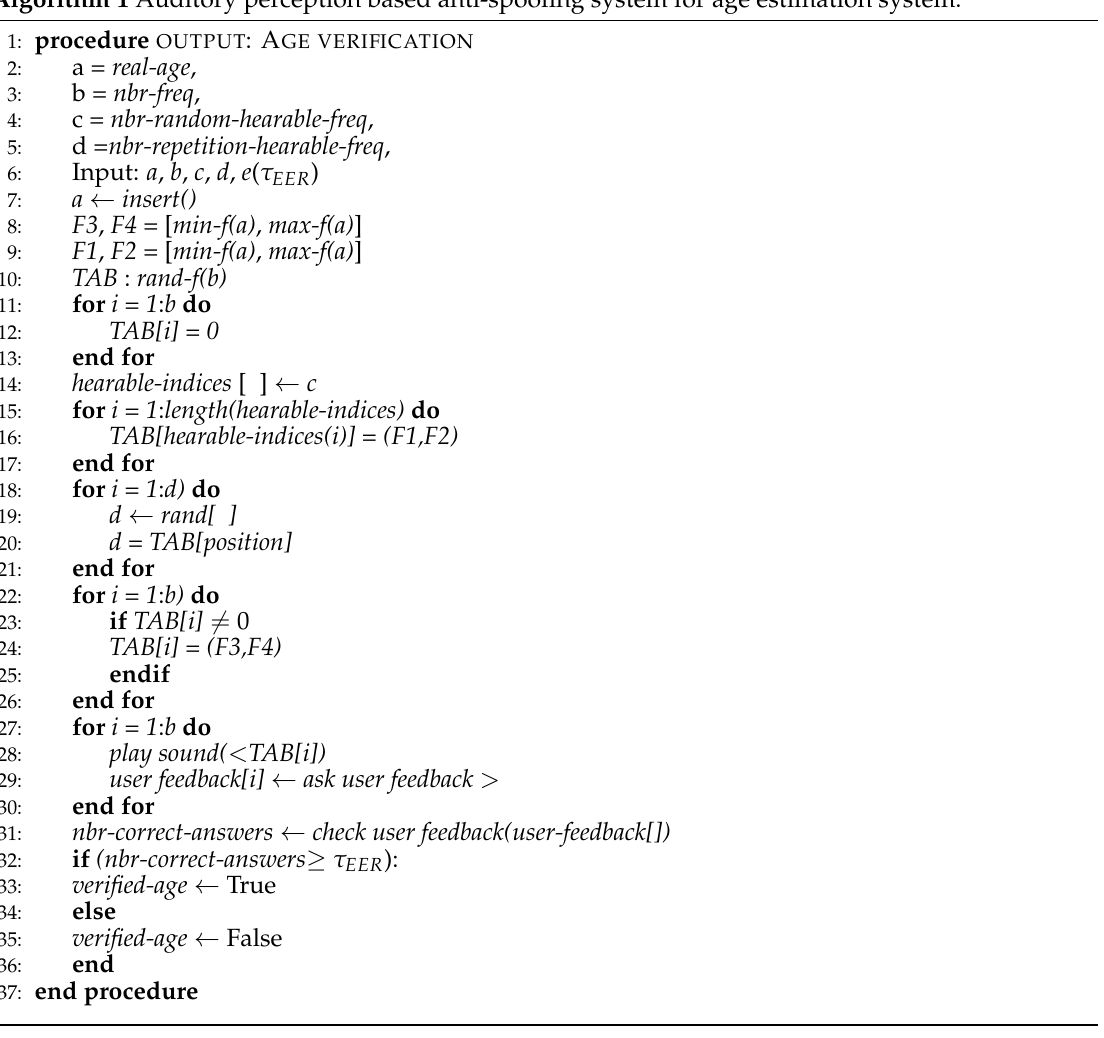
Algorithm 1 Auditory perception based anti-spoofing system for age estimation